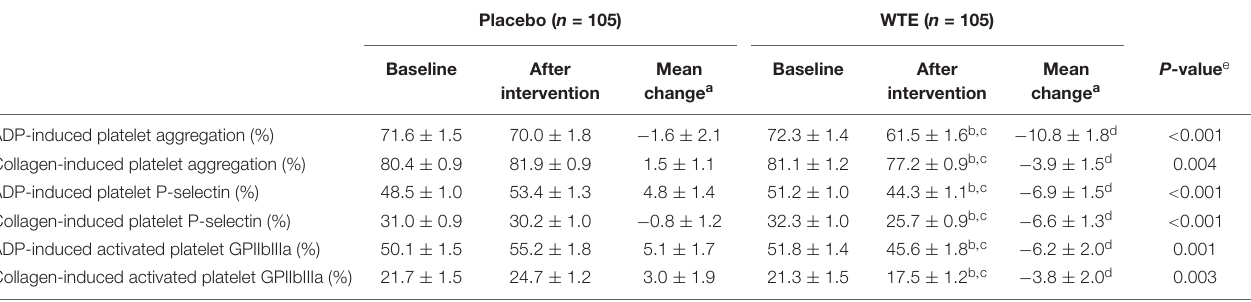
Placebo ( n = 105) WTE ( n = 105) Baseline After Mean Baseline After Mean P -value e intervention change a intervention change a